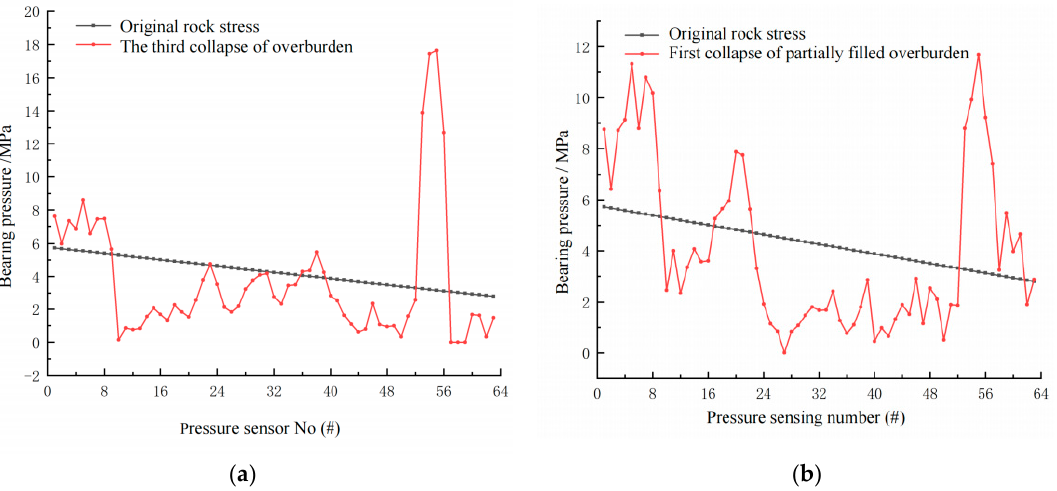
Figure 15. Bearing pressure of the floor. This figure shows the bearing pressure of the floor in no